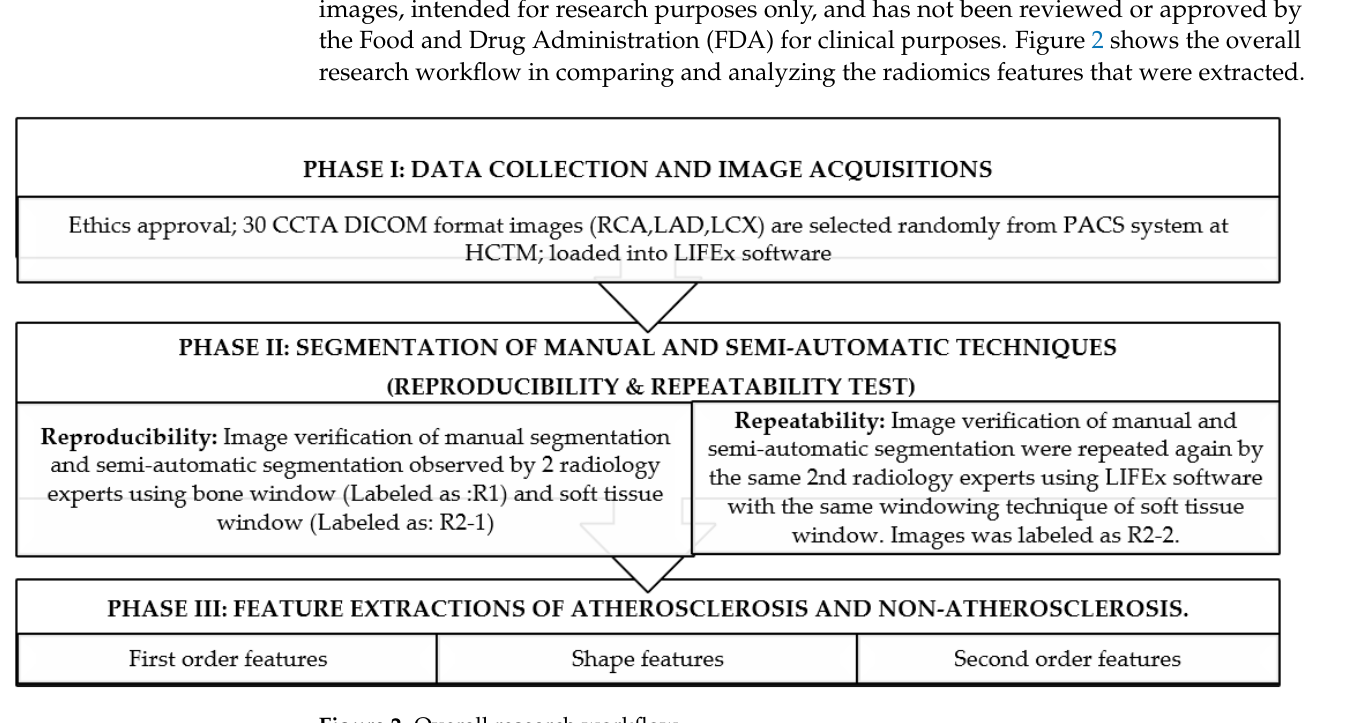
Figure 2. Overall research workflow.